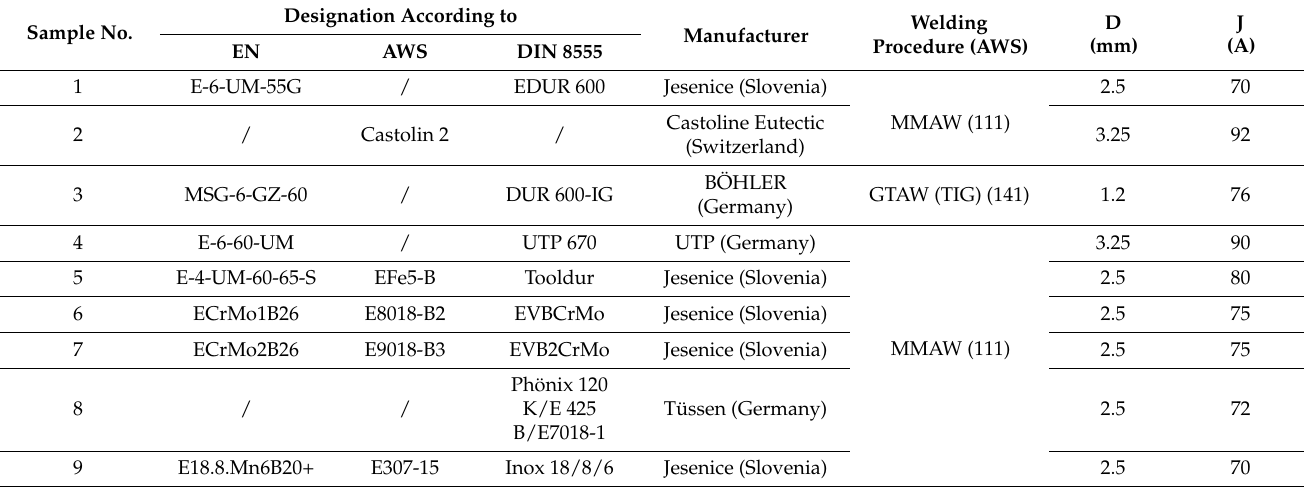
Table 4. Characteristics of the applied filler